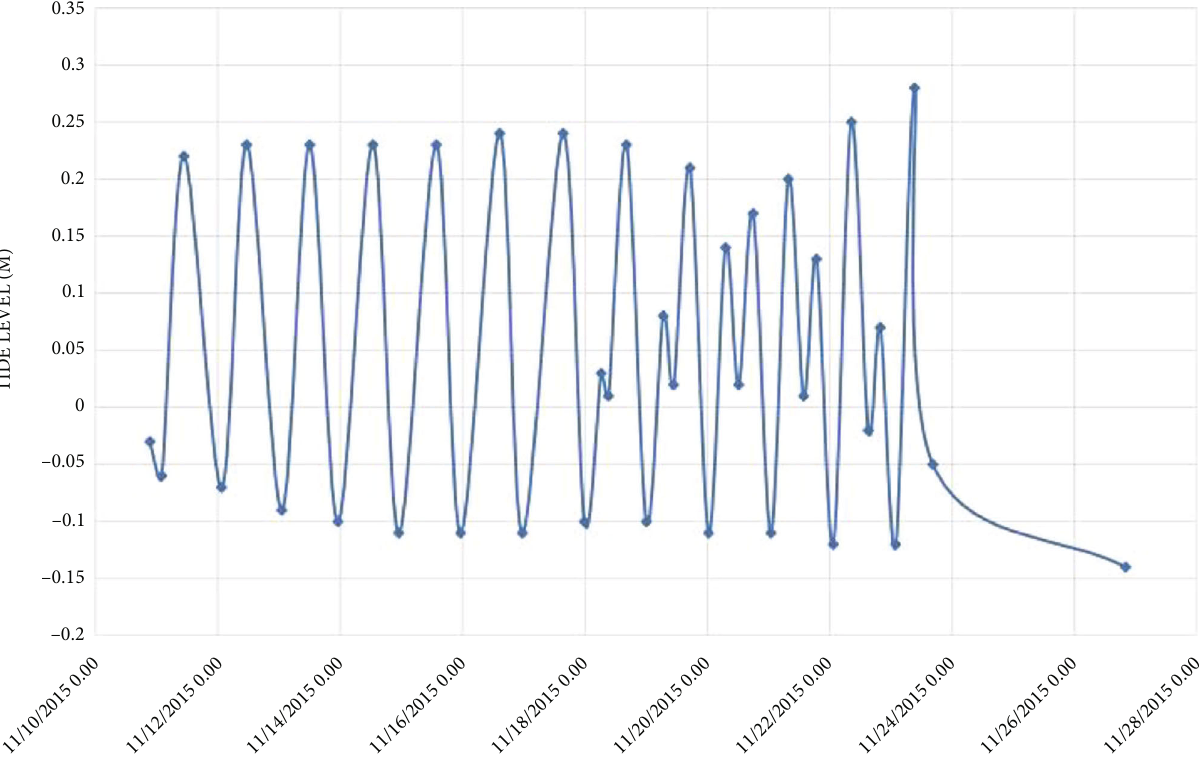
Figure 5: Tidal variation from 2010 to